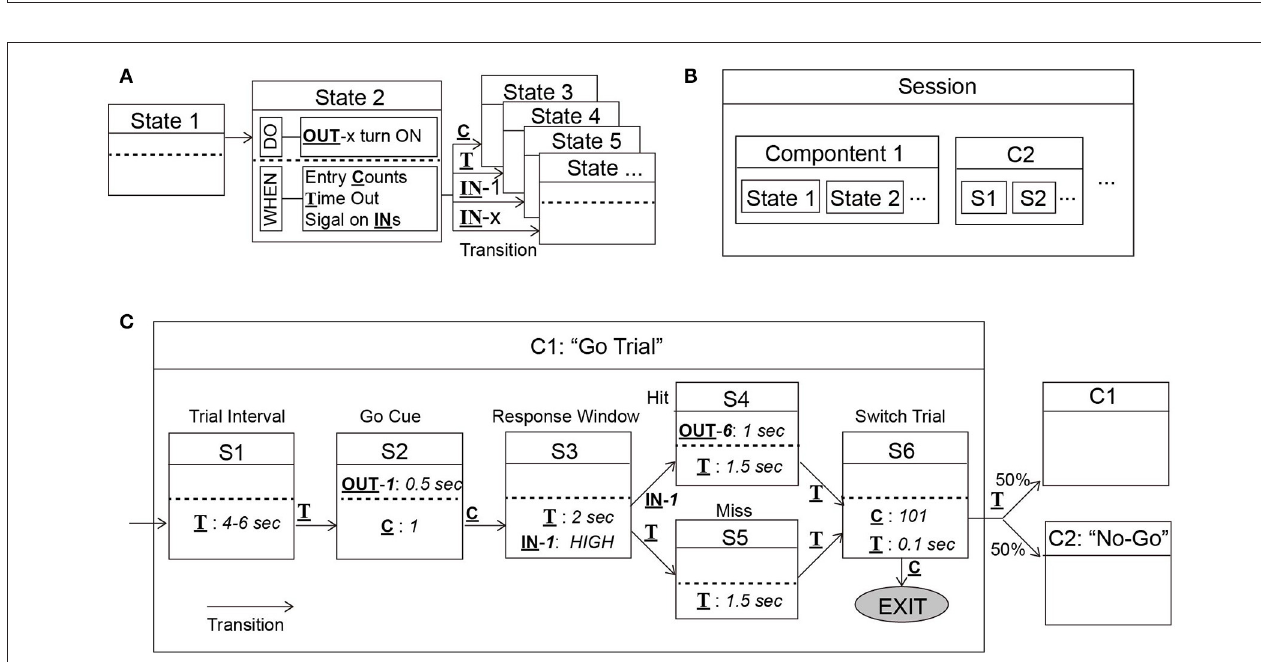
FIGURE 1 | Diagram of ArControl. (A) Hierarchic structure of ArControl. Arduino is the core pivot managing devices, operating tasks, and logging data. The host computer has corresponding GUI assistance. (B) Hardware of ArControl consists of an Arduino Uno Rev3 and a driver board for voltage conversion. (C) Driver hub provides slots for terminal devices. Sensors can work at 5V, and stimulators can work at 5 or 12V.